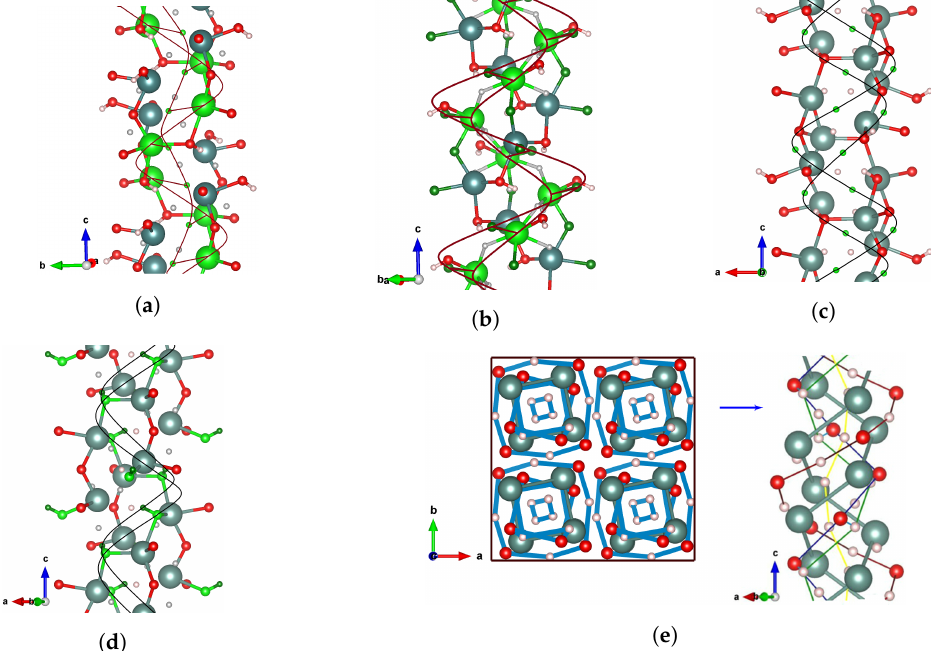
Figure 6. Scheme of a chiral packing composed of the circular helices with pitch of 9.264 Å: The color codes of atoms are the same as in Figure 2. The helical structures were parametrized in terms of functions x ( t ) = a cos ( t ) , y ( t ) = a sin ( t ) , and z ( t ) = b t , where a is the radius and the ratio b / a represents the slope. ( a ) Helical chains formed by Y(1) and H(3). Y(1): a = 2.17 Å, b / a = 0.68; H(3): a = 0.75 Å, b / a = 1.97. ( b ) Helical chains formed by Y(2) and O(1). Y(2): a = 2.17 Å, b / a = 0.68; O(1): a = 3.28 Å, b / a = 0.45. ( c ) Helical chains formed by H(1) and H(2). H(1): a = 2.27 Å, b / a = 0.65; H(2): a = 2.84 Å, b / a = 0.52. ( d ) Helical chains formed by O(2) and H(4). O(2): a = 2.17 Å, b / a = 0.68; H(4): a = 1.94 Å, b / a = 0.76. ( e ) Packing motif of the helical structure in the unit cell. A column composed of six joined helical chains represents the building block of the chiral framework of Y 2 H 3 O(OH). The internal tunnel is filled by the single H(3) helical